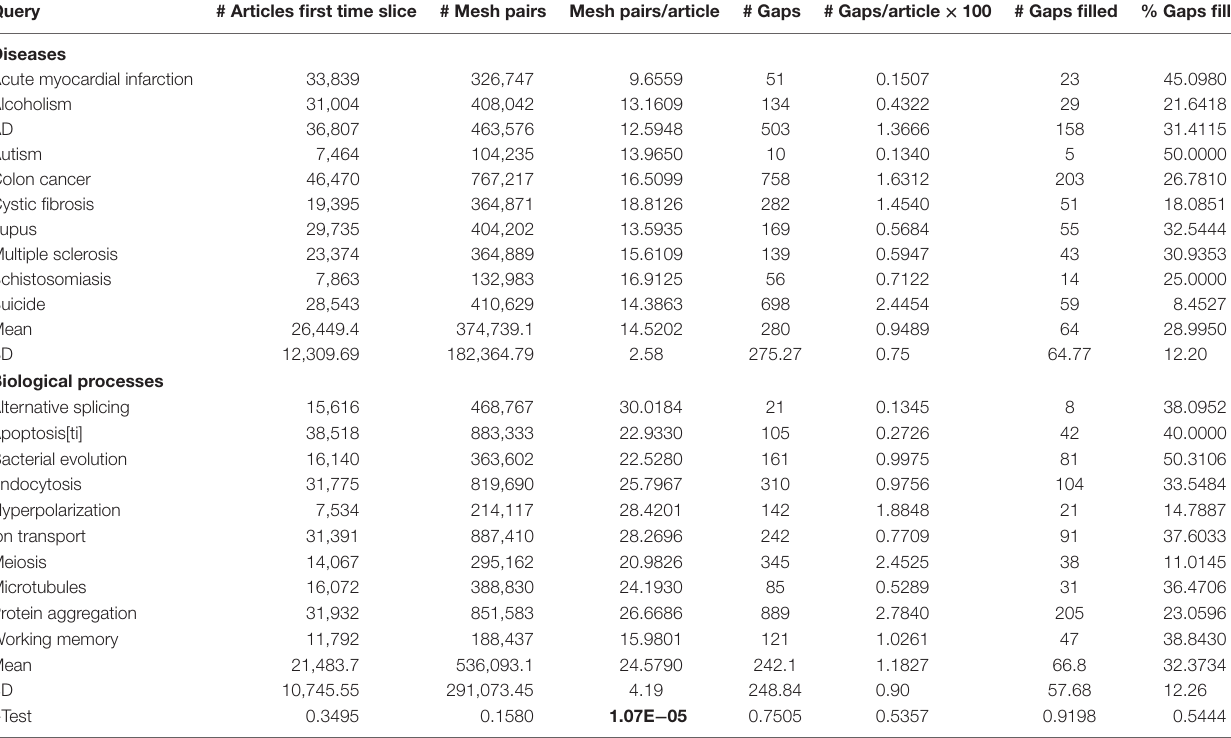
TaBle 2 | characteristics of the queries in terms of their gaps and Mesh terms.